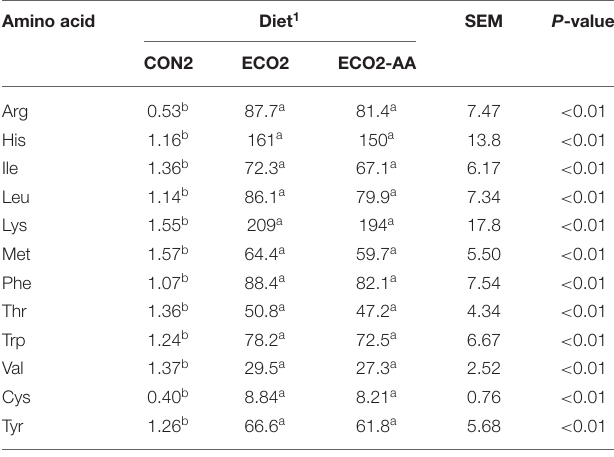
TABLE 11 | Human-edible (HE) digestible essential amino acid recovery (g output/g input) in milk of mid-lactation cows fed a conventional lactation diet or by-product-based diets (Experiment 2, Choice